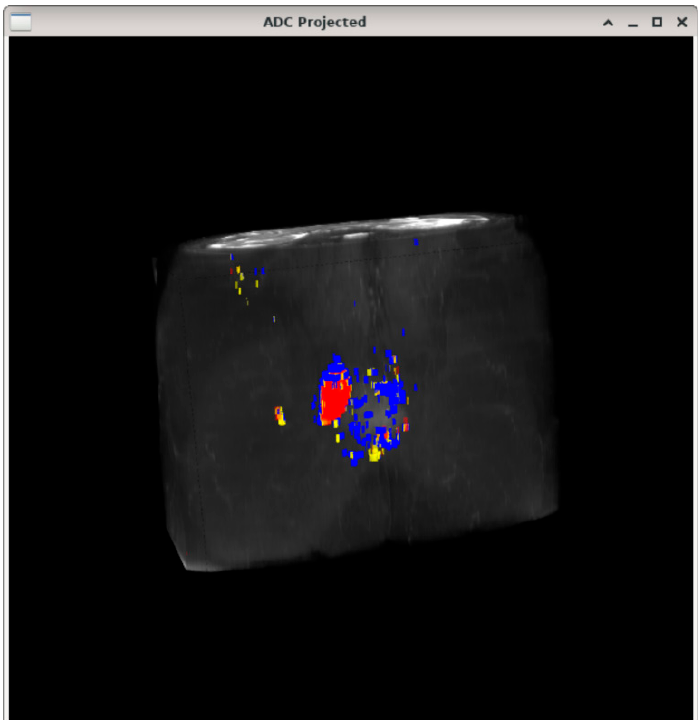
Figure 2. ADC values derived image fused on the T2-weighted sequence. The red region corresponds to the highly cellular tumor area, the blue region corresponds to the low cellular tumor area and the yellow region corresponds to the uncertain tumor area.